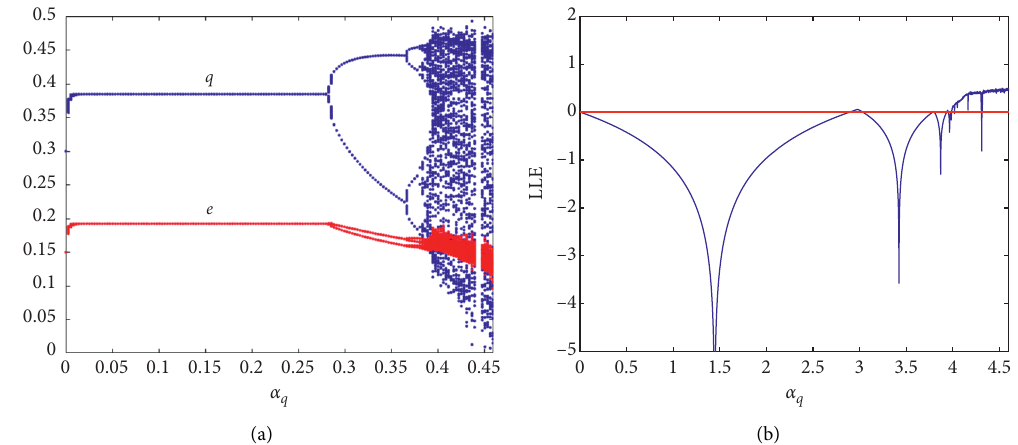
Figure 4: The bifurcation diagram of dynamic system (25) with respect to α diagram.